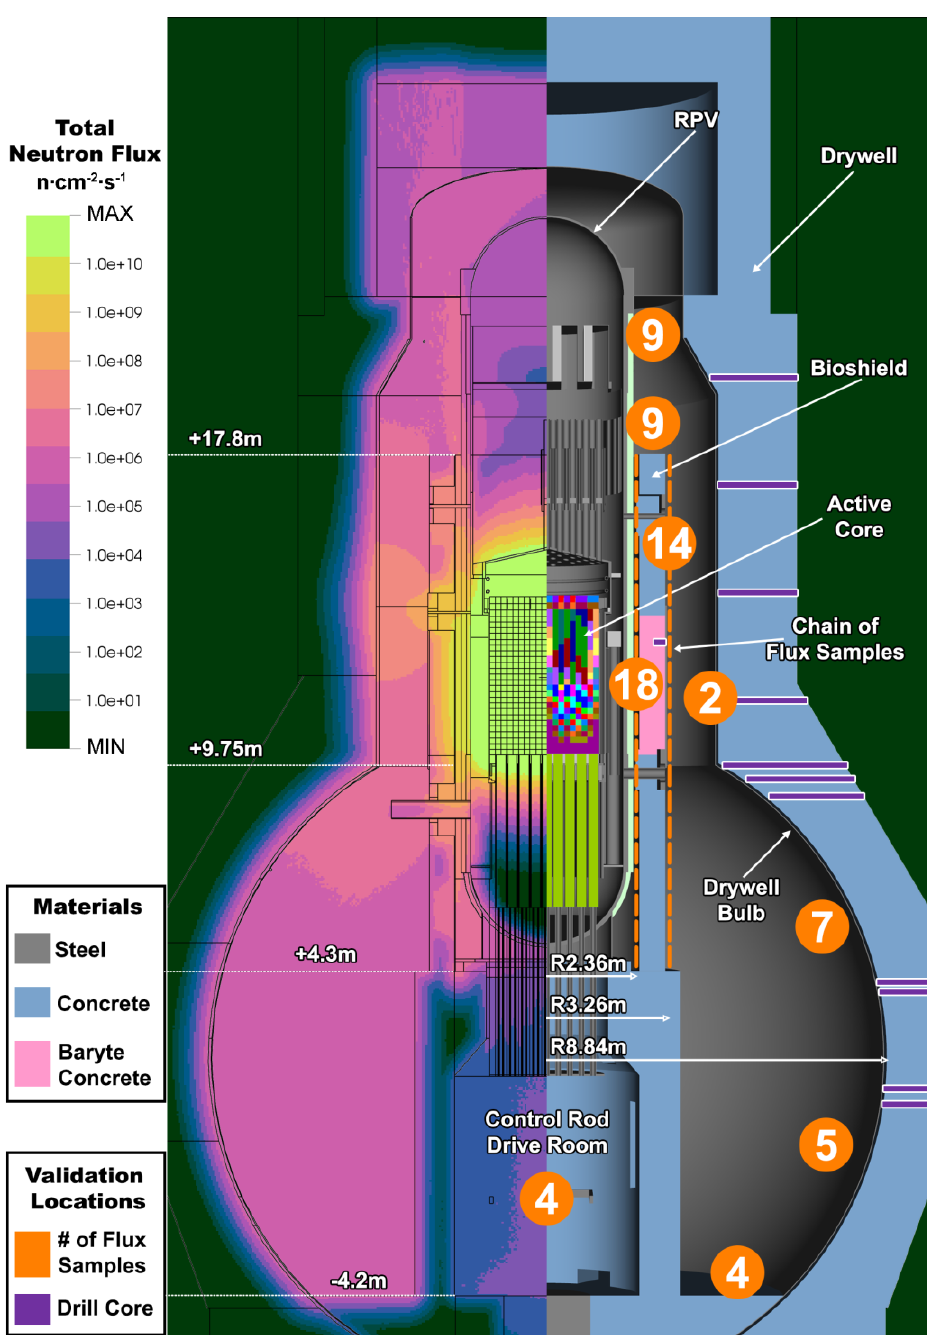
Figure 1. MCNP model of KKM, showing the total neutron flux distribution (left) and the modeled geometry (right), including a summary of the locations of the flux samples and the drill cores. The geometry is color-coded based on the material type. The number of flux samples in a particular area are indicated within orange circles. The locations of drill cores are indicated using purple rectangles. Key dimensions are provided as orientation for the sample positions defined in subsequent